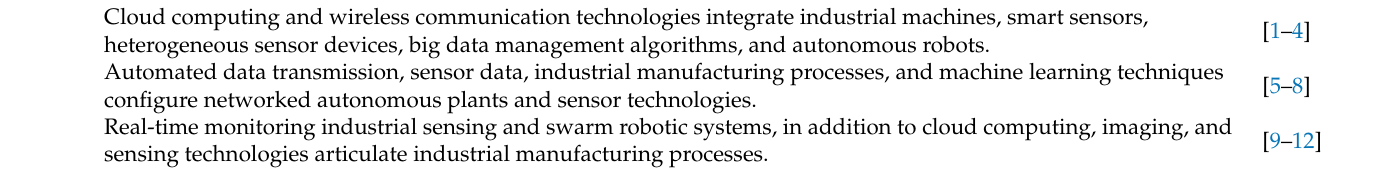
Table 2. Synopsis of cumulative evidence in relation to inspected topics and descriptive results (research